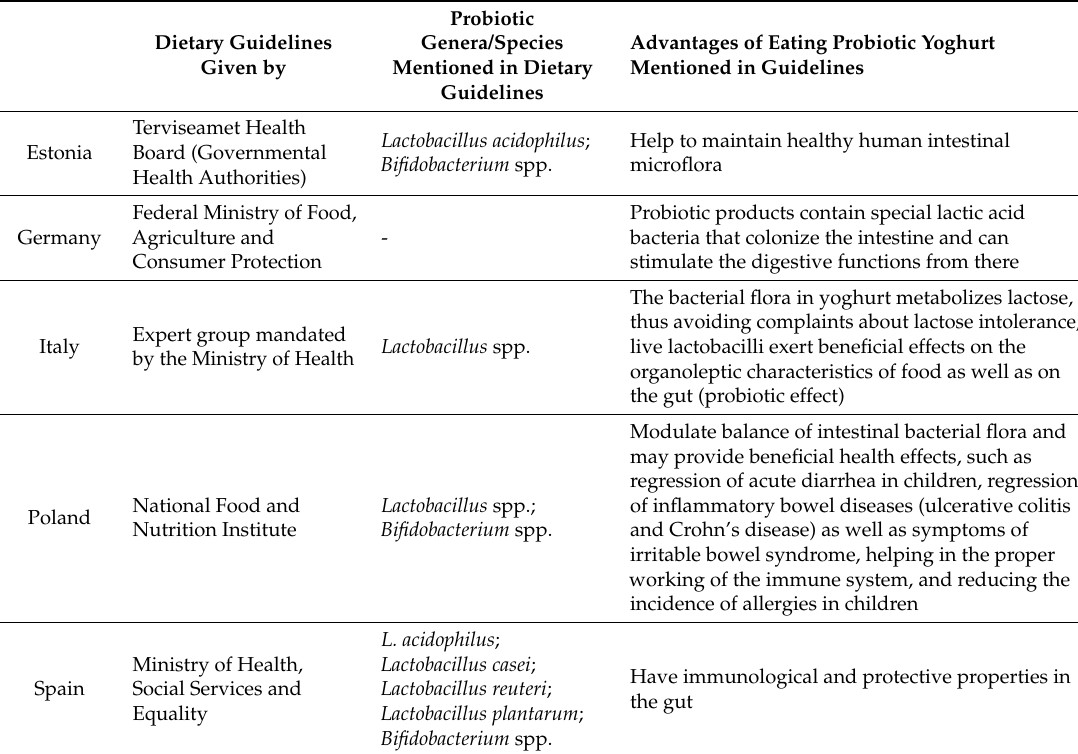
Table 1. European Union member states explicitly mentioning yoghurt and probiotics in their nutrition guidelines or recommendations (taken from